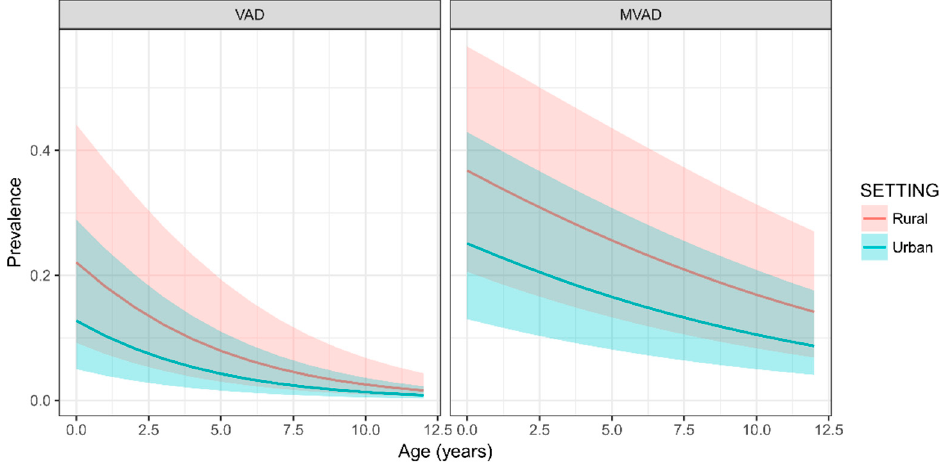
Figure 2. The setting-specific relationship between age and prevalence of VAD and MVAD in Chinese children.